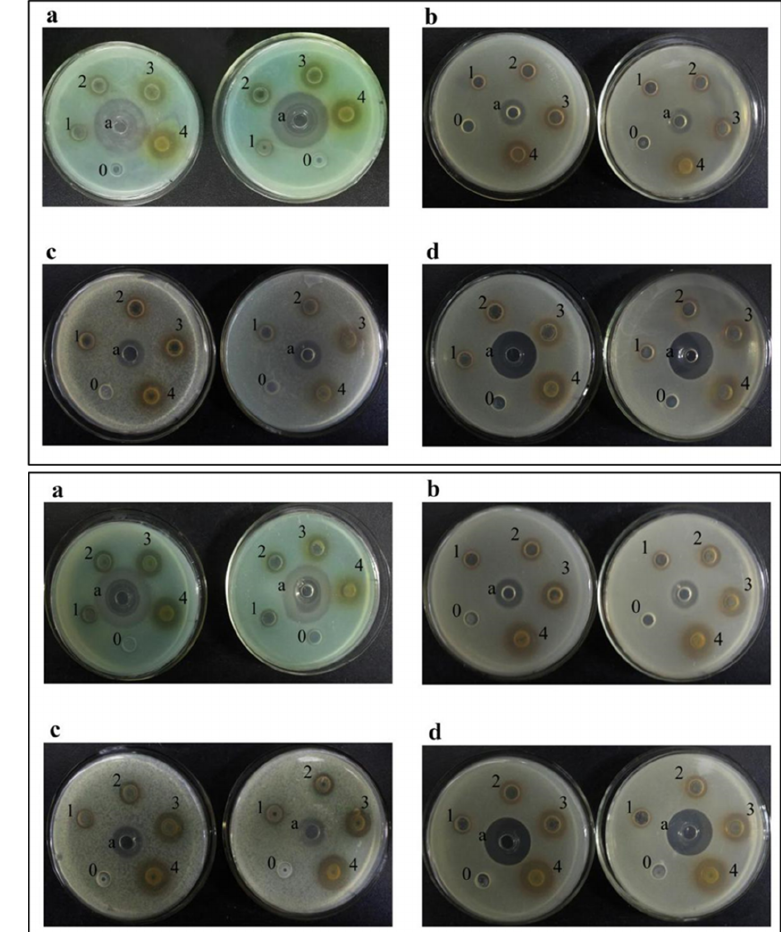
Figure 2. The antibacterial effect of ECTs from the DLP ( A ) and DLS ( B ): ( a ) Pseudomonas aeruginosa , ( b ) Escherichia coli , ( c ) Salmonella and ( d ) Staphylococcus aureus . Wells 0, 1, 2, 3 and 4 represent ECT concentrations of 0, 3.125, 6.25, 12.5 and 25 mg/mL, respectively. The middle wells are the positive control represented by a. Table 3. The antibacterial effect of polyphenols extracted from longan pericarps (A) and seeds (B). Concentration of ECTs